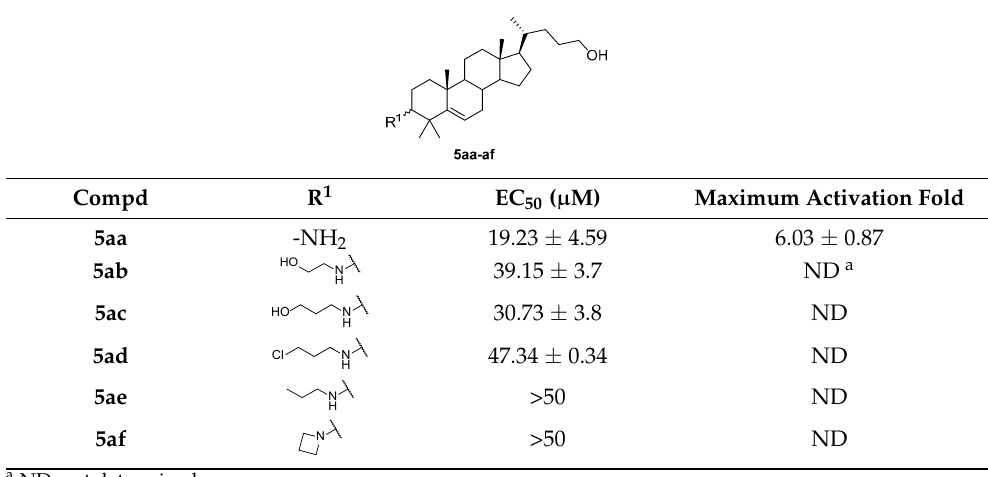
Table 1. SHP1-activating effects of compounds 5aa-af .